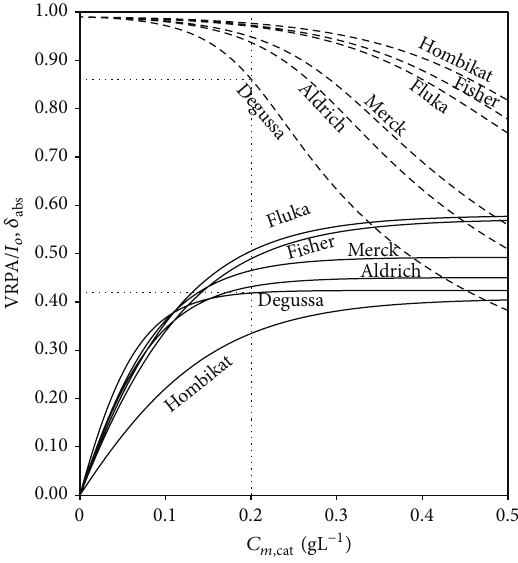
Figure 3: Design parameters of a flat plate solar photoreactor for different commercial brands of TiO 2 as a function of its loading. VRPA/ 𝐼 0 (cm −1 ): (—); boundary layer thickness of photon (cm): absorption 𝛿 abs